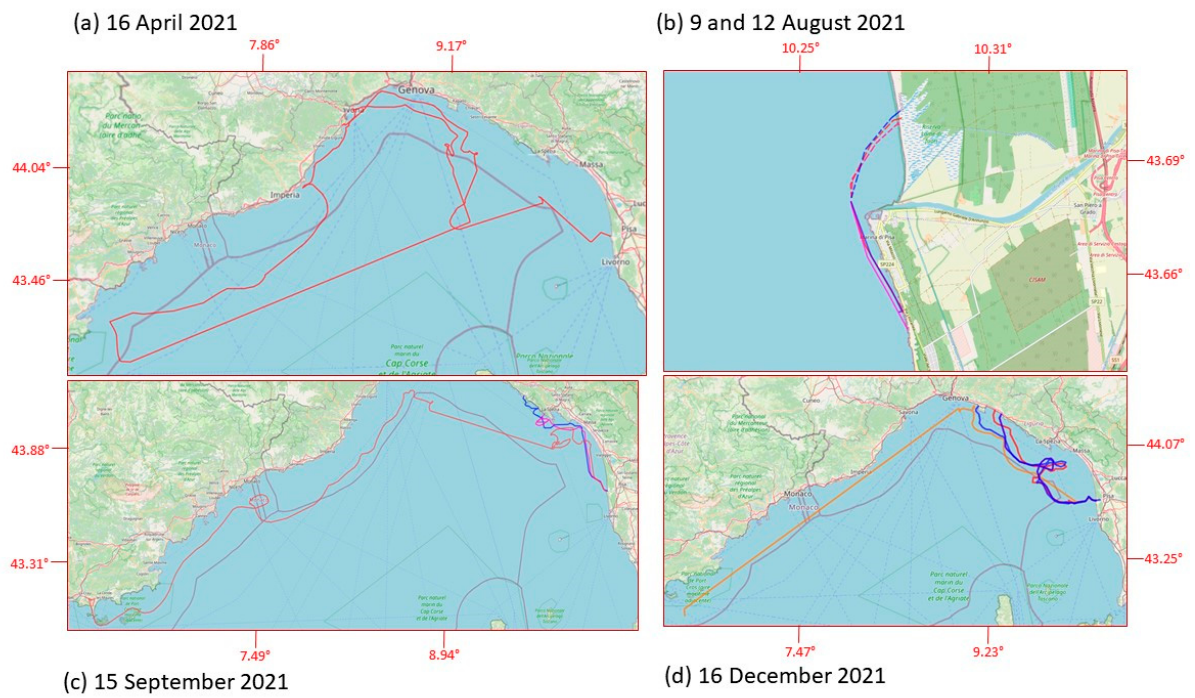
Figure 6. Trajectories of MLT during the 5 launches performed in 2021 (time is expressed according to CET/CEST). Box ( a ) display the launch of 16 April; box ( b ) contains the two launches of 9 (dotted lines) and 12 August; box ( c ) display the launch of 15 September and box ( d ) the one of 16 December. The comparison of the 4 pictures outlines the differences in the dispersion and beaching scenarios of the same type of MLTs in the same coastal area but in different seasons. It is noteworthy that the only MLTs that reached French coastal waters were tablet-shaped.